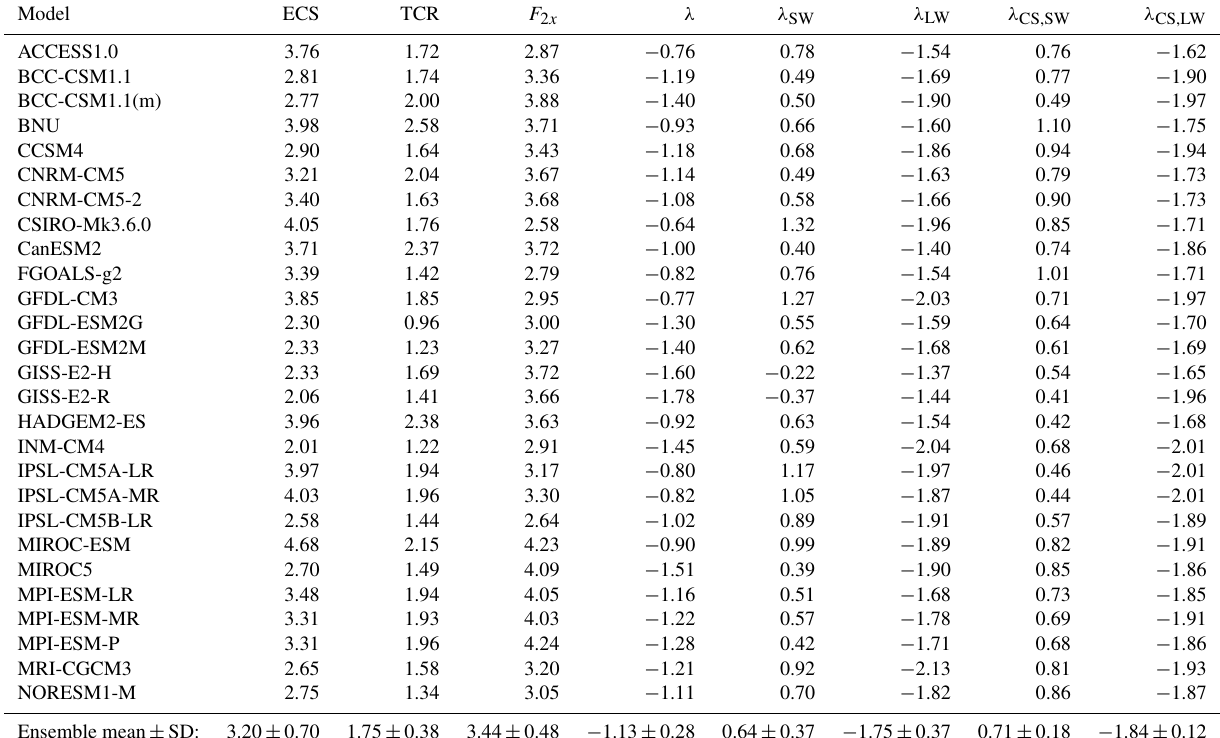
Table 1. List of CMIP5 models and model climate parameters. Model